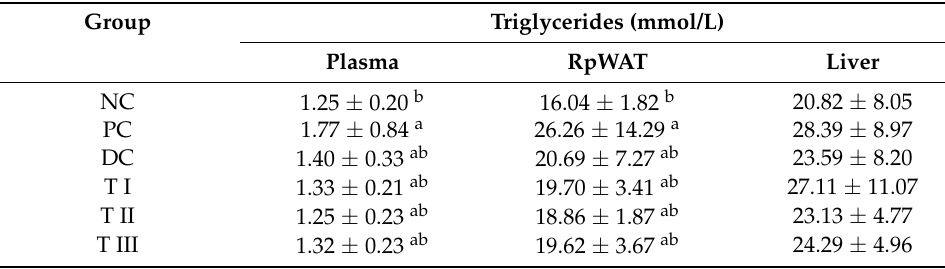
Table 4. Anti-obesity effect of E. tapos shell extract on